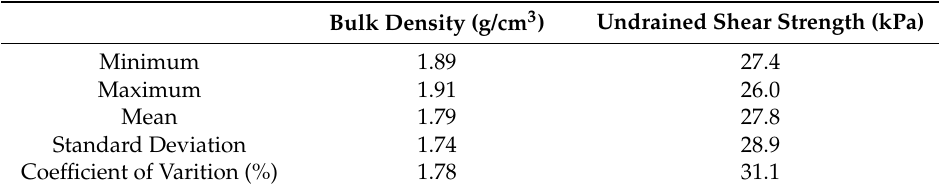
Table 2. Statistics obtained from all 51